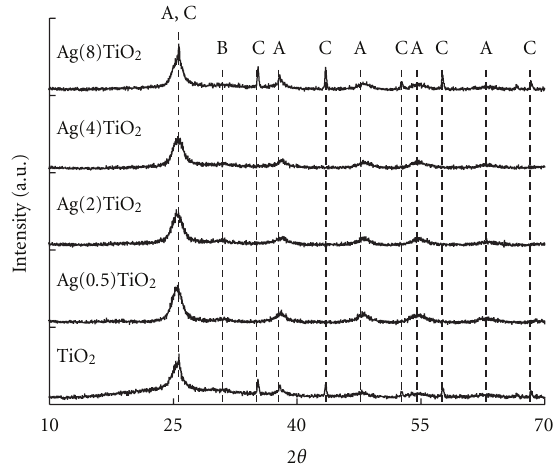
Figure 3: X-ray di ff ractograms of the TiO 2 and Ag-TiO 2 samples. A: Anatase, B: Brookite, C: Al 2 O 3 Corundum.